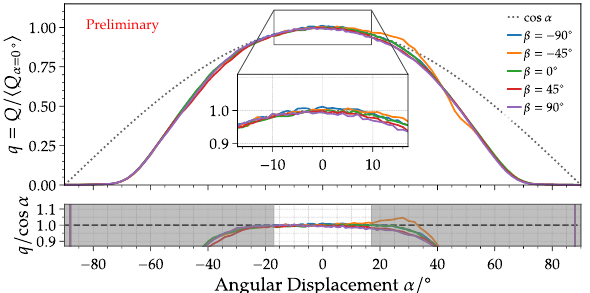
Figure 6. The emission profile of the calibration light source. Angular displacement area of interest corresponding to the field of view of Auger FD telescope is from − 16° to 16°.